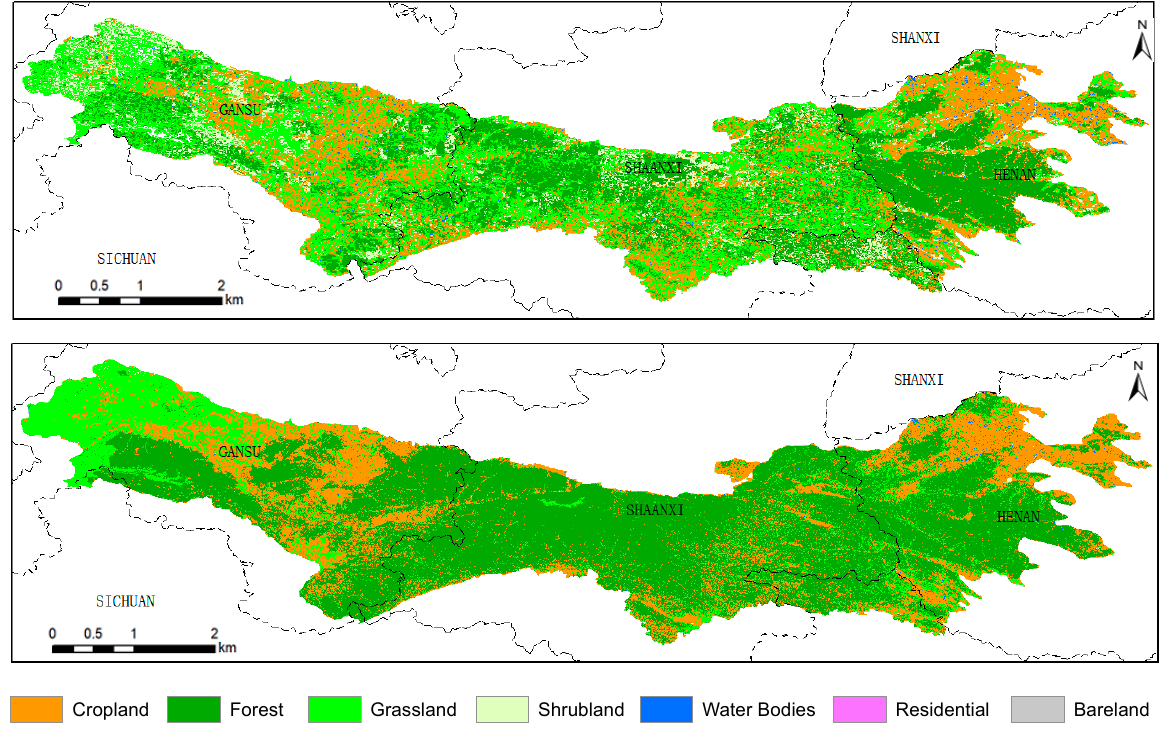
Figure 3. Spatial distribution of landcover in the Qin Mountains in 1990 and 2017.